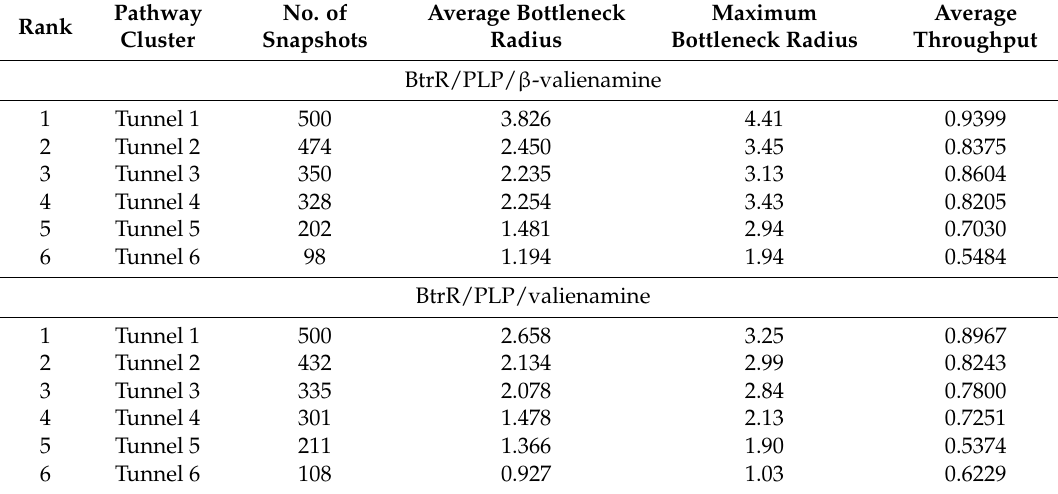
Table 3. The top-ranked tunnels of bottleneck residues of BtrR identified using CAVER 3.0 according to the MD simulations